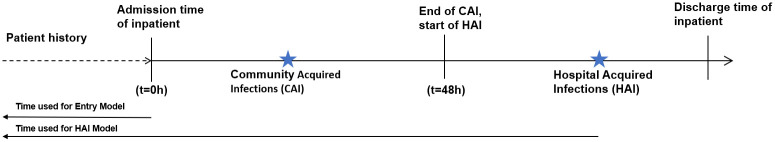
Illustration of the time lines of the two predictive models; the entry model and the HA-UTI model.